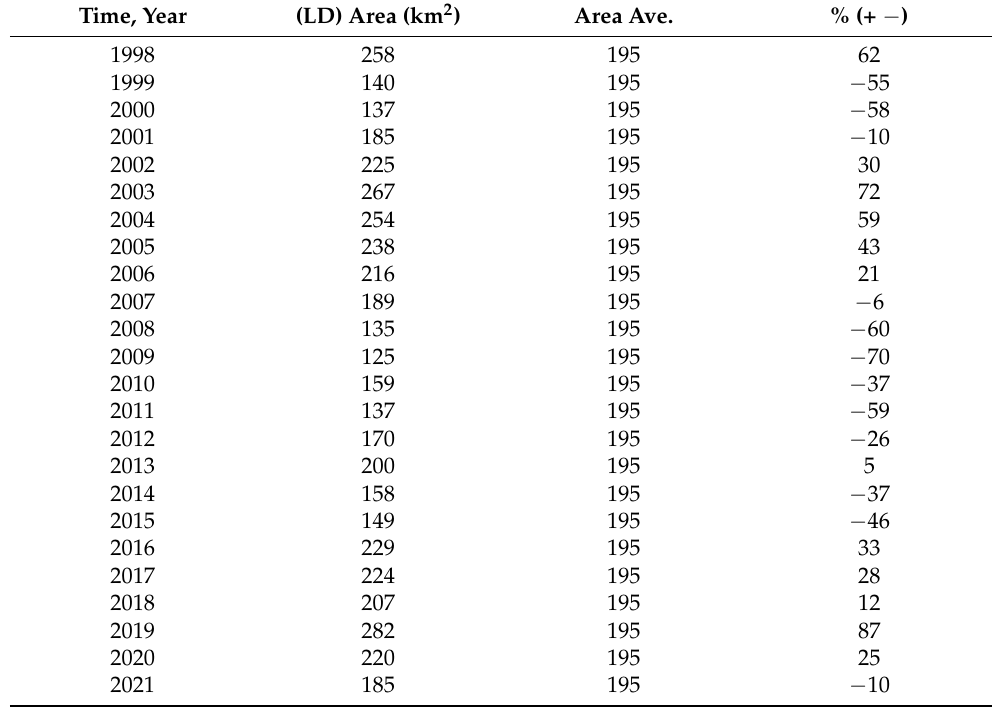
Table 3. Area of water body in (LD) for 1998–2021. Time, Year (LD) Area (km 2 ) Area